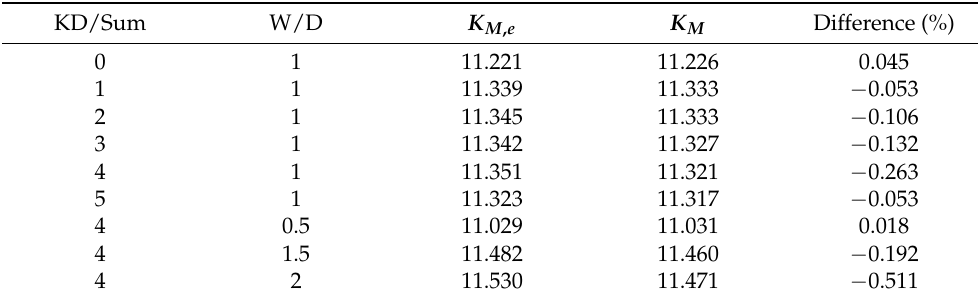
Table 10. Comparison between the moment initial stiffness coefficients of a spudcan embedded in pure elastic and elastic perfectly plastic